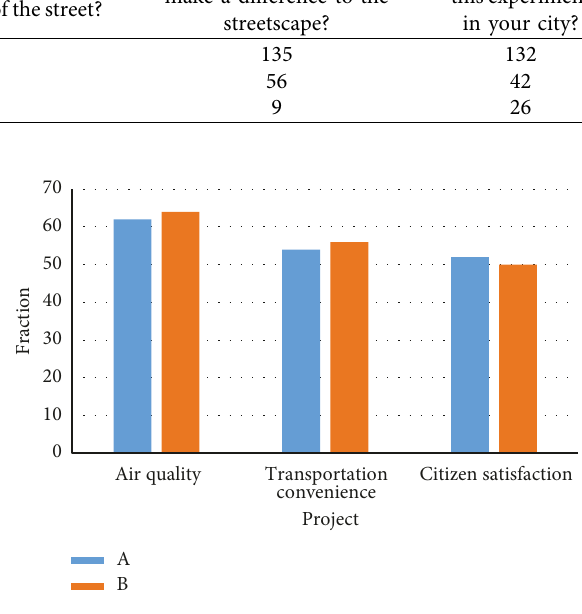
Figure 8: The air quality, accessibility, and satisfaction of citizens in city A and